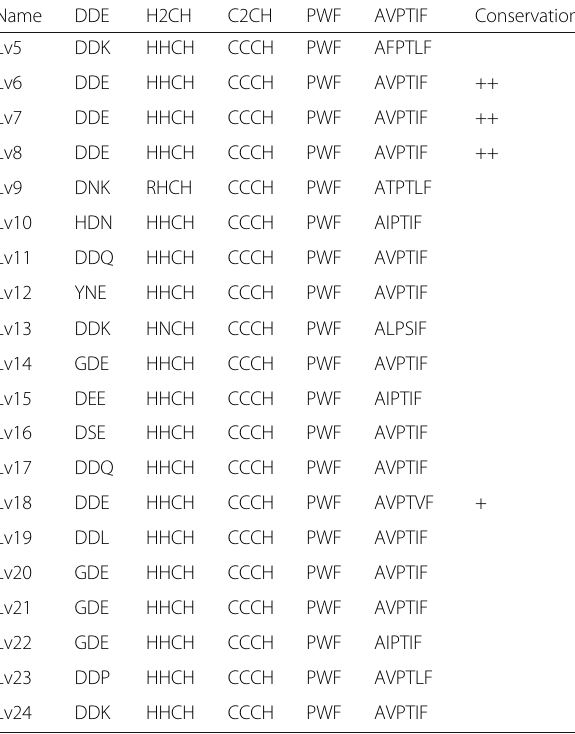
Table 2 Amino acid residues in conserved motifs of Kolobok transposase